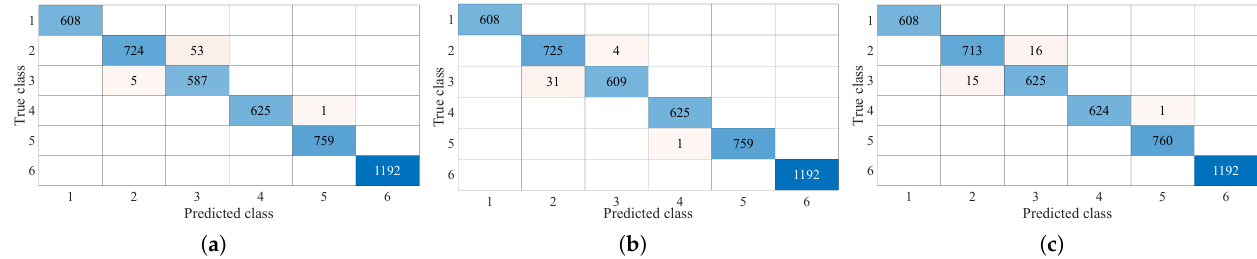
Figure 12. Confusion matrix for the ( a ) designed Matlab AdaBoostM2 method using sixty decision tree learners, a feature depth of seven, a minimum leaf size of three and a learning rate of 0.61992; ( b ) designed XGBoost method, which produced a generalization error of 0.7905%; ( c ) designed DNN, which produced a generalization error of 0.7027%. The predictors are as follows: (1) noise (2) WiFi (3) router (4) Bluetooth advertising (5) CW and (6)